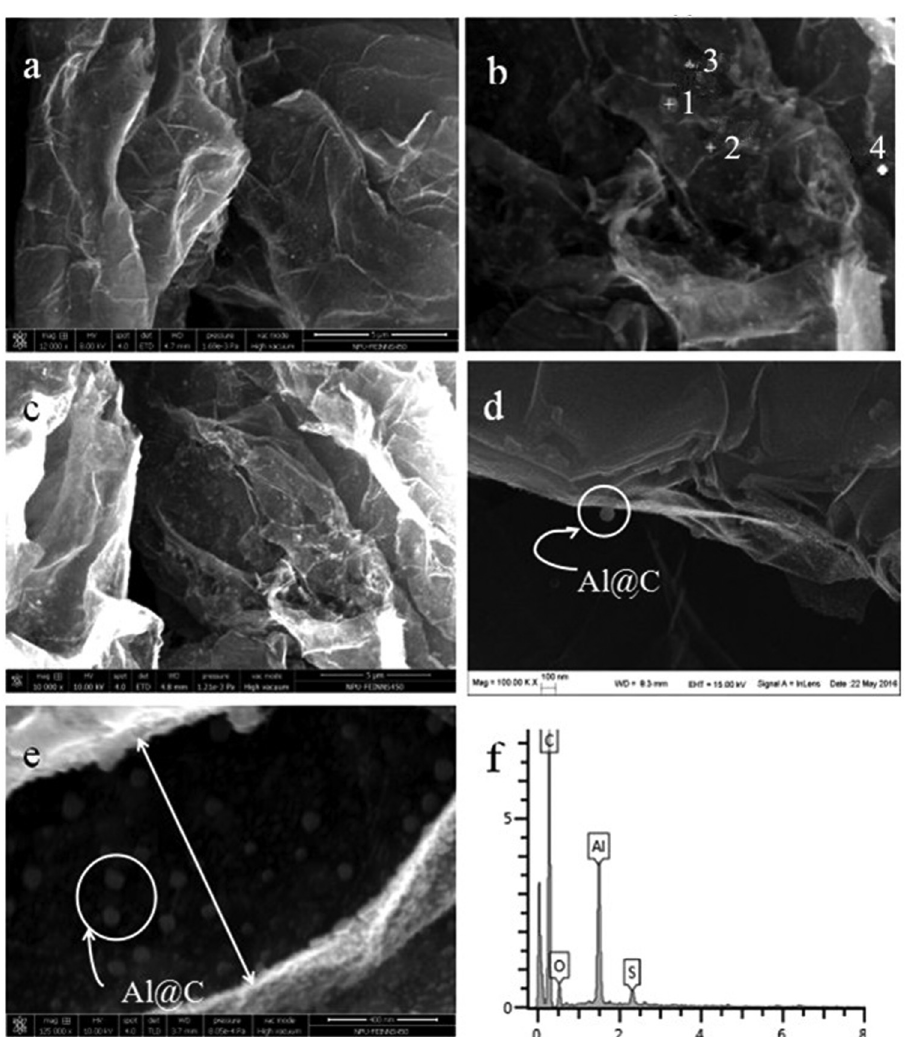
Figure 2: SEM images and corresponding EDX elemental analysis of C@Al – EG